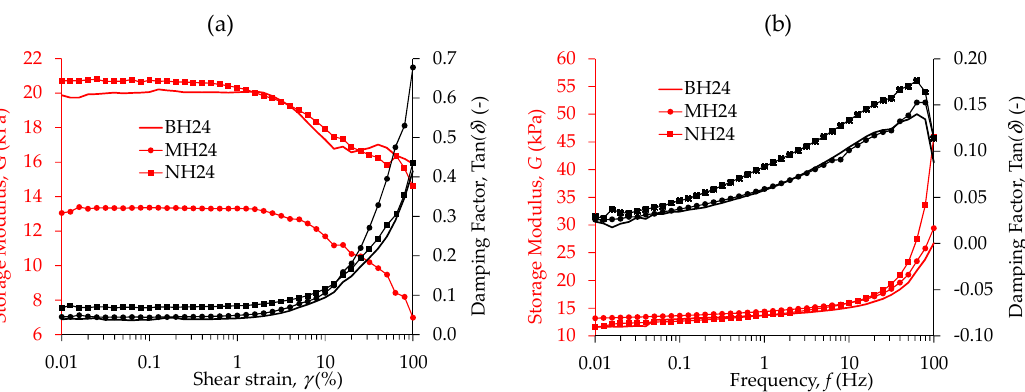
Figure 7. ( a ) Curve of storage modulus G’ and damping factor tan ( δ ) obtained from rheological test with controlled shear strain, f = 10 Hz and B = 0; ( b ) storage modulus G’ and damping factor tan ( δ ) obtained from plate-to-plate rheological test with controlled frequency with γ = 1% and B = 0.